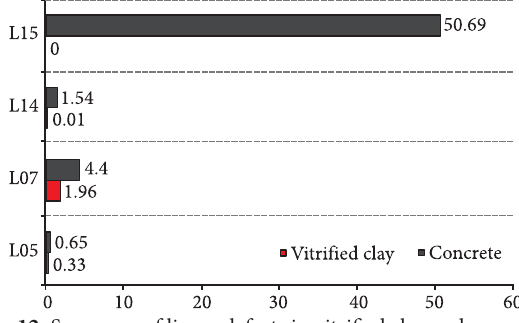
Fig. 12. Summary of linear defects in vitrified clay and concrete sewers, in